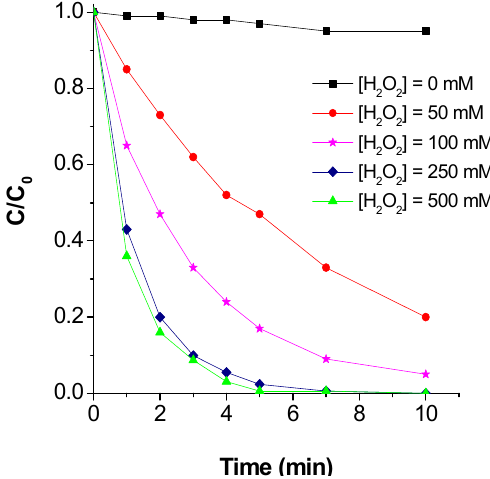
Figure 9. Influence of initial hydrogen peroxide concentration in the degradation of a lipophilic compound (DPPH) by CWPO using Au/CNT as catalyst ([DPPH] 0 = 0.2 mM, [catalyst] = 1.0 mg/mL, T = room temperature, stirring = 600 rpm). Adapted from Lorençon et al. [88].